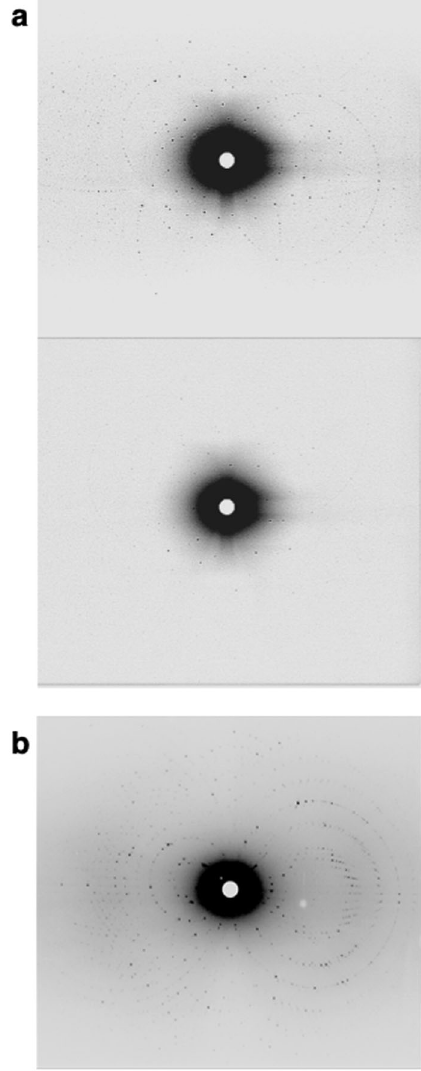
Fig. 4 Comparison of neutron diffraction of perdeuterated TS crystals from PCG-15. a 16-h Laue diffraction image collected using wavelengths 2.8 to 10 Å from 0.2 mm 3 microgravity-grown pD-TS crystal (top). The fl ight crystal diffracted to 3.2 Å. 16-h Laue diffraction image (2.8 – 10 Å) from 0.2 mm 3 ground control pD-TS crystal (bottom). The ground control crystal diffracted to 4.0 Å and exhibited a much weaker diffraction pattern. Neutron diffraction data was collected on IMAGINE at ORNL. b A quasi-Laue diffraction image (2.85 – 3.8 Å) of a large (>1 mm 3 ) microgravity-grown pD-TS crystal 19-h collected on LADI-III at ILL, which diffracted to 2.1